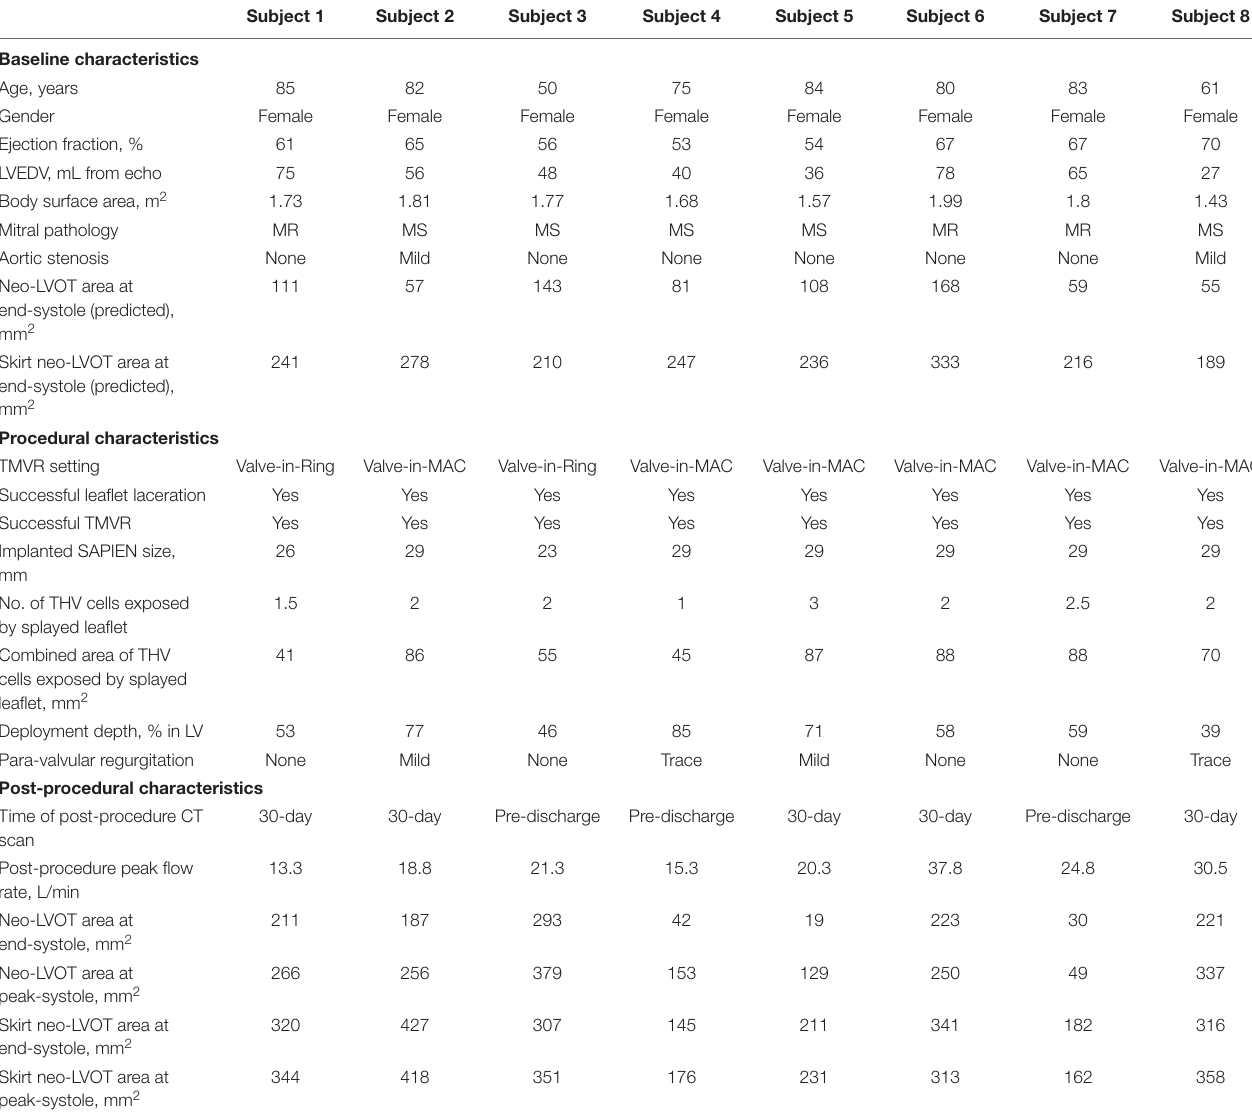
TABLE 1 | Baseline, procedural, and post-procedural